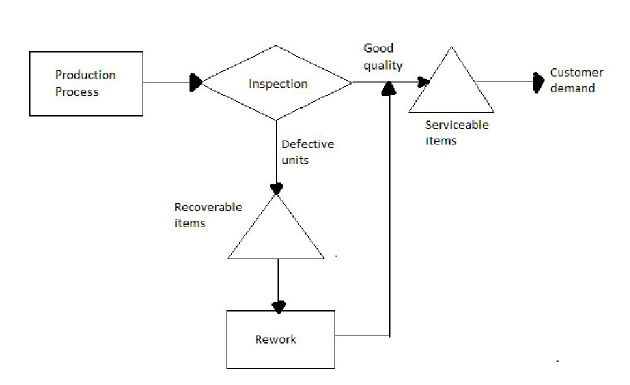
Fig. 1. The production system with